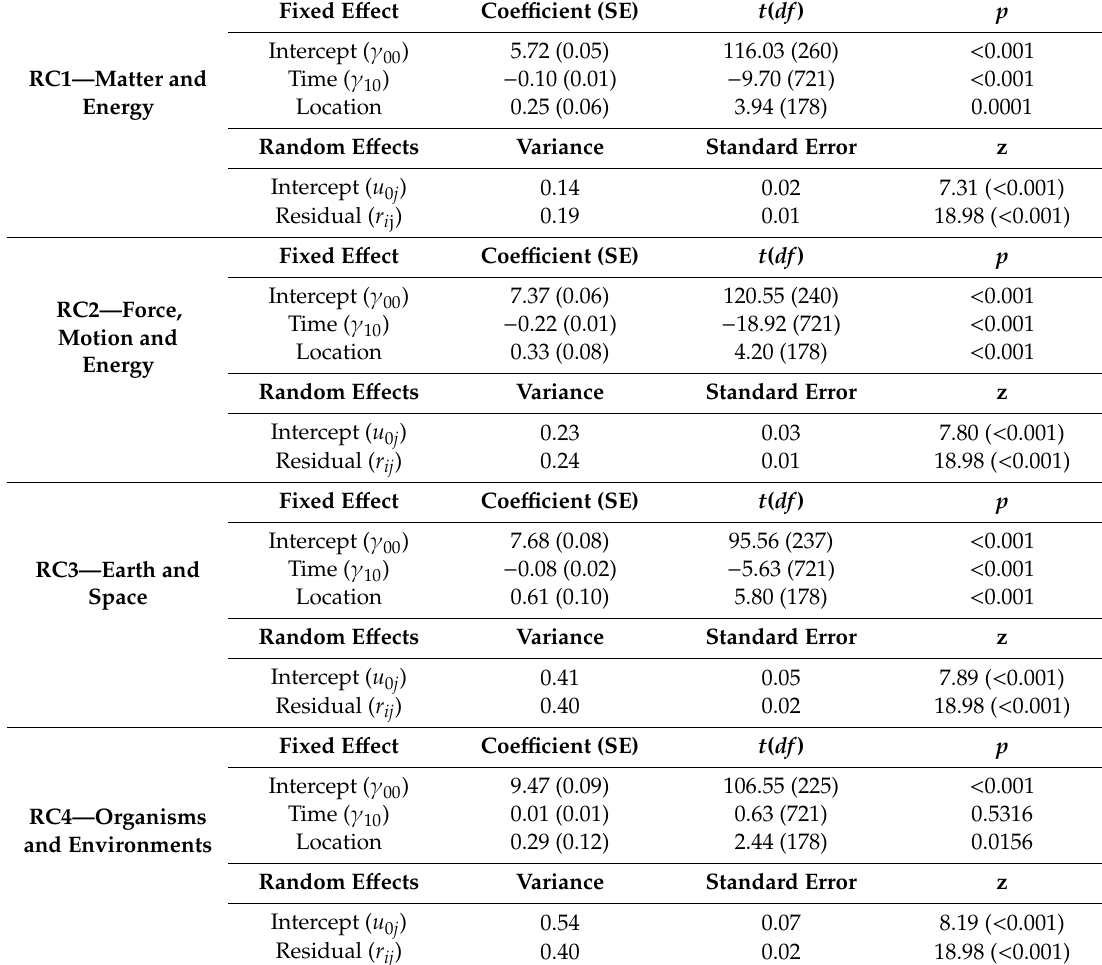
Table 5. Parameter estimates of fixed and random e ff ects of Model 3 by reporting